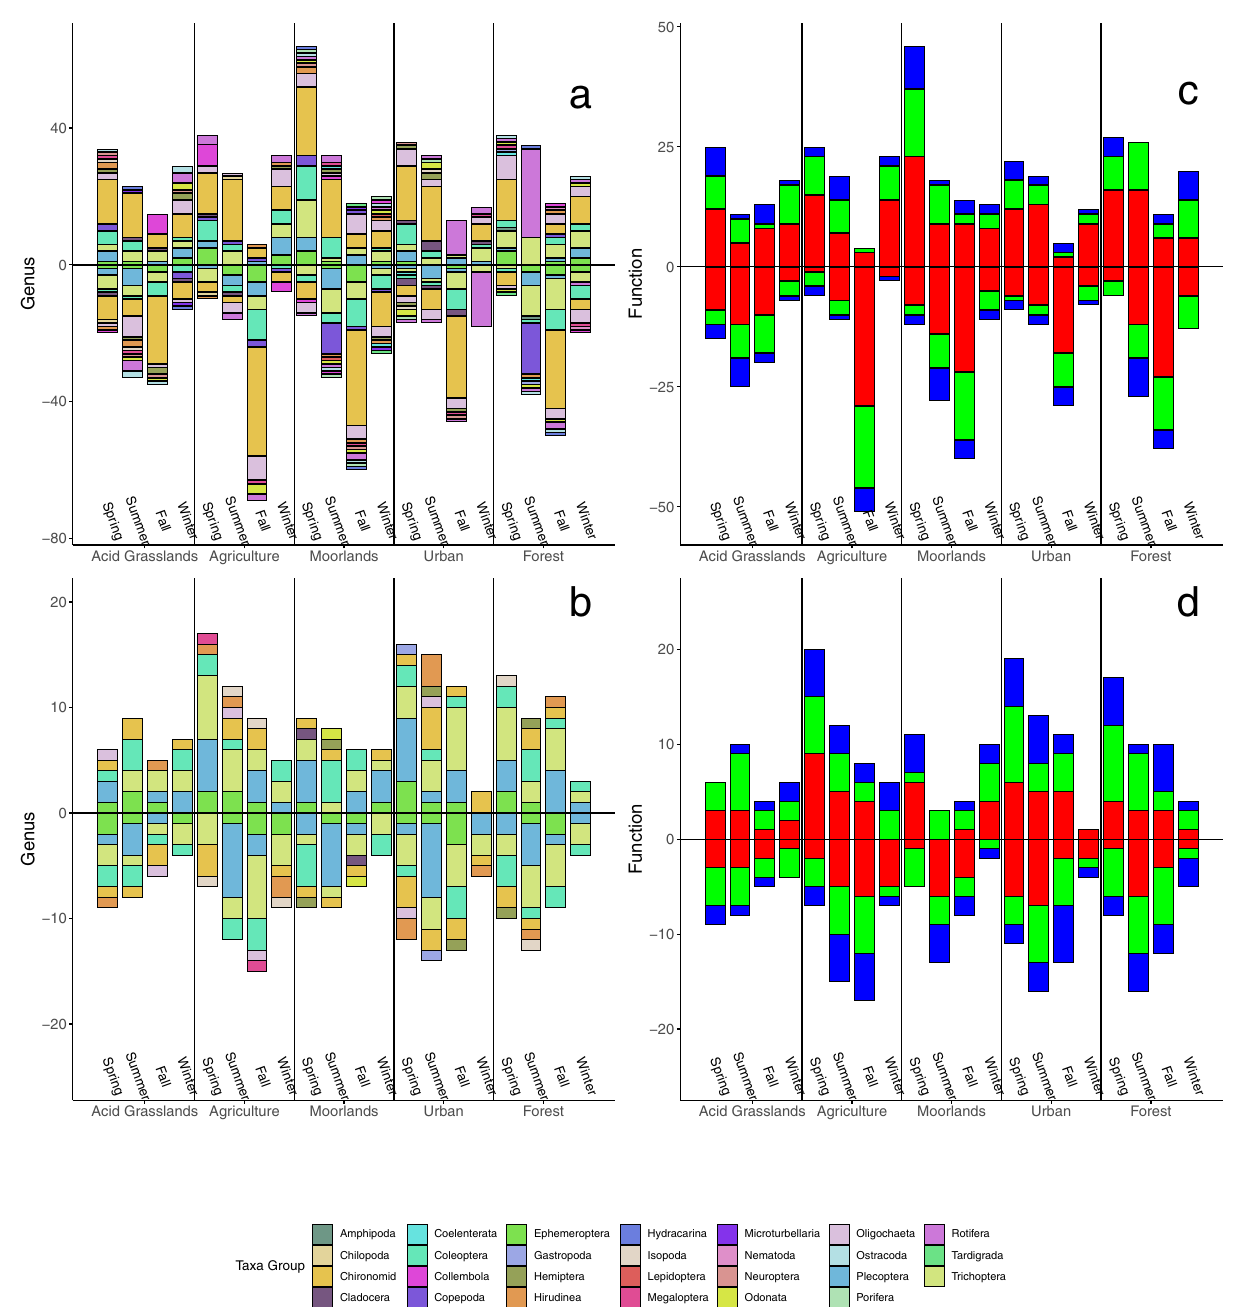
Fig. 6 Family and functional community compositional change over time. Change in genera richness for eDNA ( a ) and traditional sampling ( b ) and the associated change in function for eDNA ( c ) and traditional ( d ) sampling. Each subpanel is a unique landuse type showing the sequential change in genera or function whereby values above the line indicate additions in genera or function compared to the previous season and values below the horizontal line indicate loses. Colors for the genera plots are unique taxa groups, provided in the legend, and each value along the y -axis is a unique genus loss or gain. Functional group colors are: scraper = blue, collector = red, gatherer = green. Sample sizes were 56 for eDNA (average of each sites ’ 3 replicate samping) and 56 for traditional